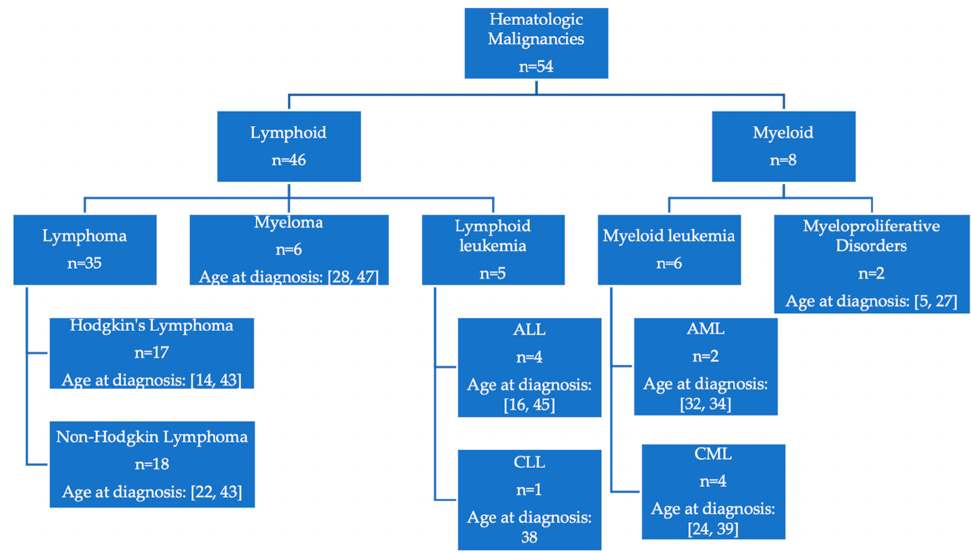
Figure 5. Distribution and range of age at diagnosis of hematologic malignancies in EYA. ALL = Acute lymphoblastic leukemia; AML = Acute myeloid leukemia; CLL = Chronic lymphocytic leukemia; CML = Chronic myelogenous leukemia.